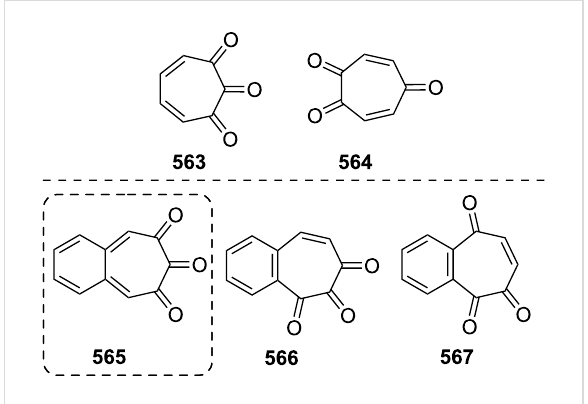
Figure 35: o / p -Tropoquinone rings ( 563 and 564 ) and benzotropo- quinones ( 565 – 567 ).